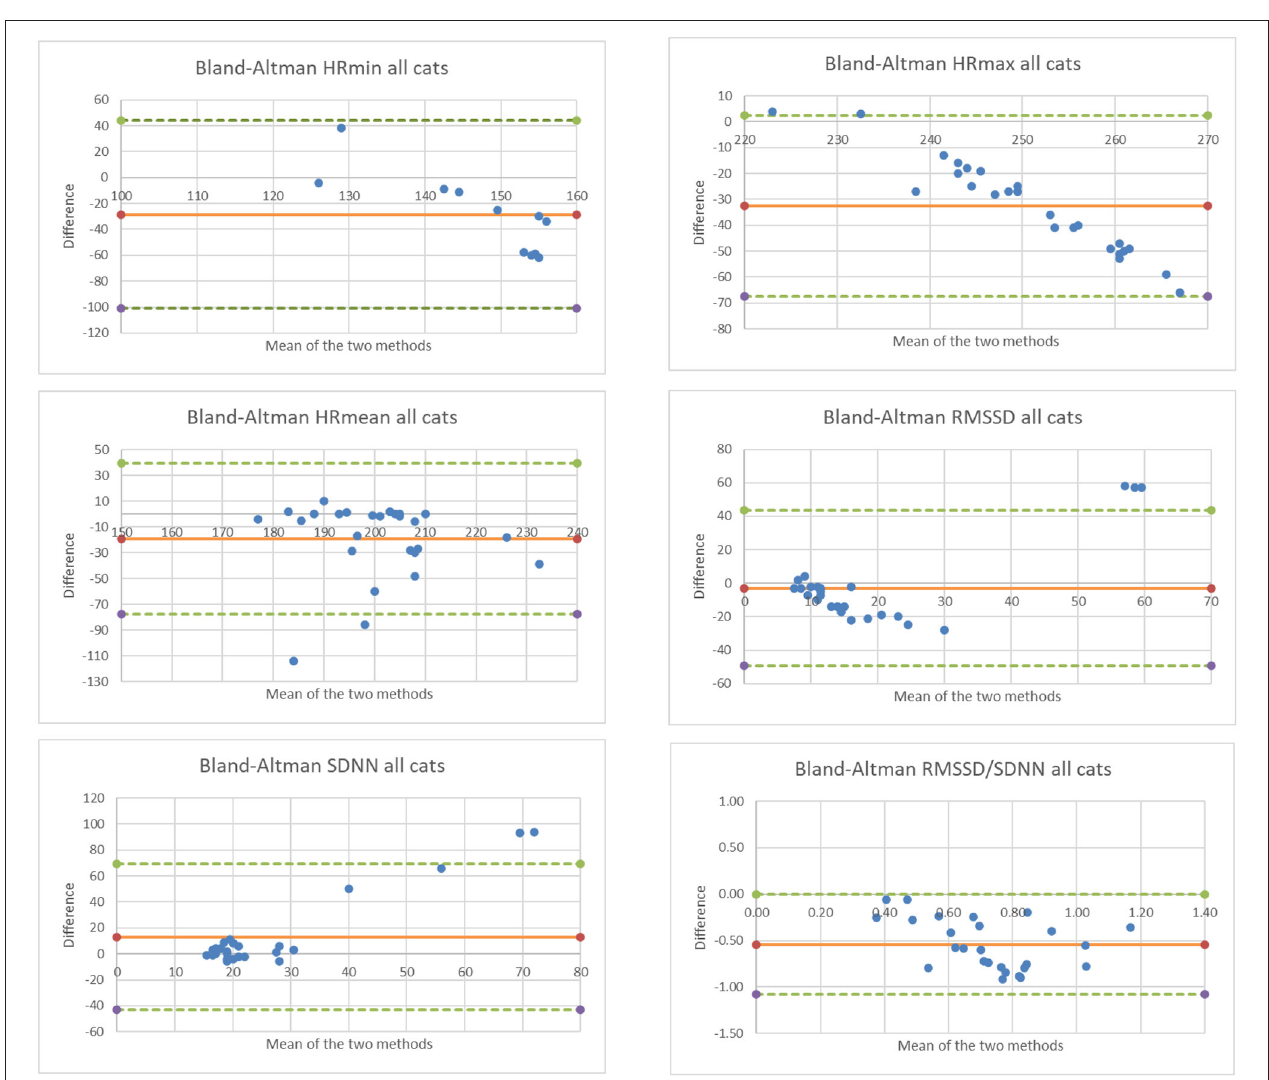
FIGURE 2 | Bland Altman plots comparing data collected for 5 cats and for all cardiac parameters using the two methods. Note that the x-axis represents the mean measurement (Holter and Polar H10), and the y-axis represents the difference between measurements (Polar H10 minus Holter).